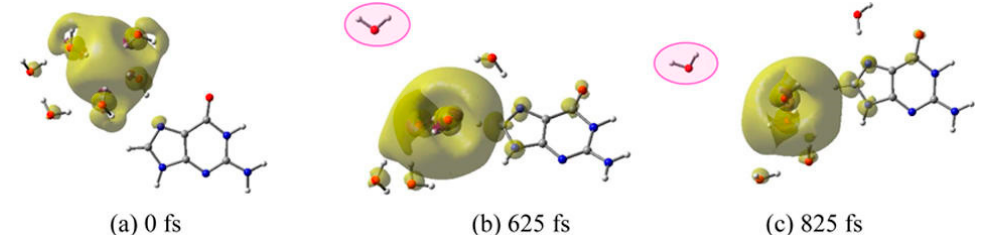
Figure 8. Total spin density plot of guanine (G)–6H 2 O • − at different times during MD simulation. ( a ) 0 fs (initial optimized starting structure for simulation), ( b ) 625 fs, and ( c ) 825 fs. The 6H 2 O is located near the N7 − C8 site of guanine. Reprinted with permission from reference [72]. Copyright, 2016, American Chemical Society.